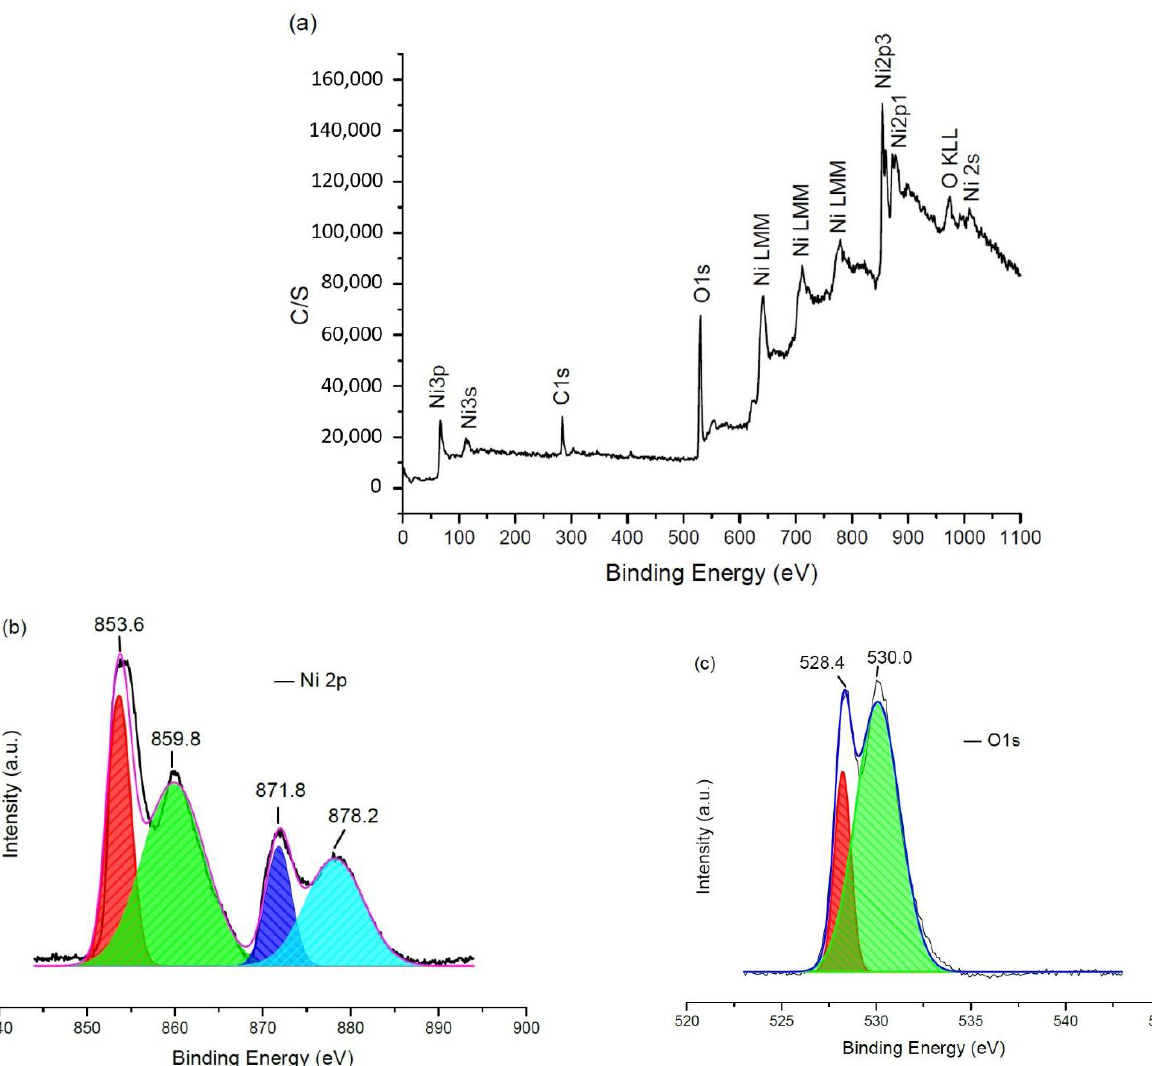
Figure 4. XPS analyses of the NiO film: ( a ) full spectrum; ( b ) Ni 2p; and ( c )